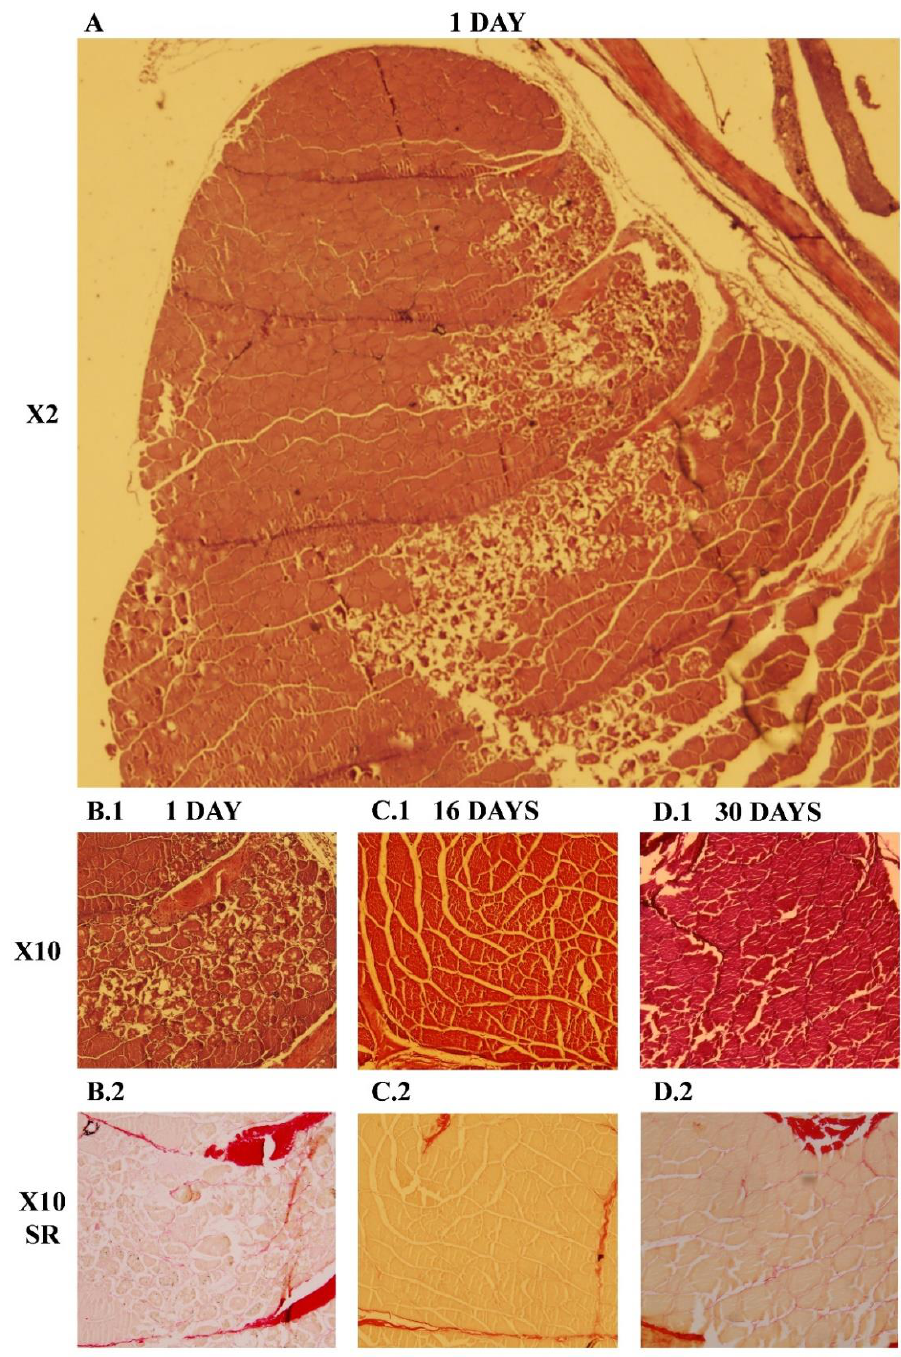
Figure 5. Histological evaluation of the muscle regeneration process at 1 ( B.1 , B.2 ); 16 ( C.1 , C.2 ) and 30 ( D.1 , D.2 ) days post injury. Muscle sections (7 – 10 µm) were stained with hematoxylin/eosin ( A , B.1 , C.1 , D.1 ) and Sirius red ( B.2 , C.2 , D.2 ). X2 and X10 means 2× and 10× objective magnification, respectively. Ocular magnification was 10×. SR = Sirius red